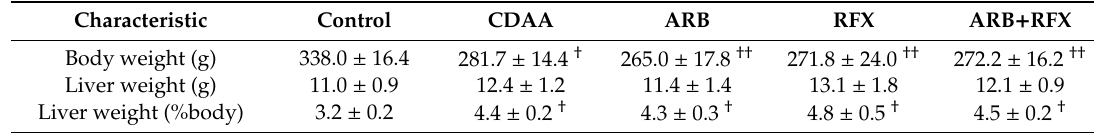
Table 1. Characteristic features of the experimental groups.